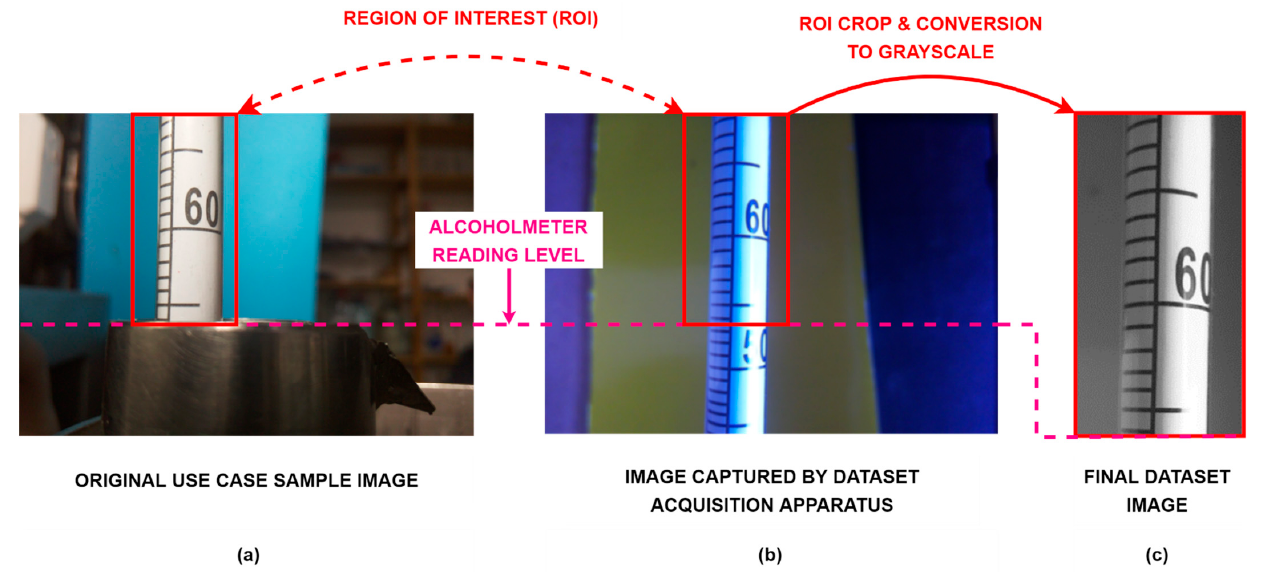
Figure 8. Illustration of dataset image generation and preprocessing procedure: ( a ) Original use case sample image is displayed with region of interest (ROI) labeled with red rectangle and alcoholmeter reading level labeled with pink dashed line; ( b ) Image captured by dataset acquisition apparatus together with ROI corresponding to original use case ROI and alcoholmeter reading level; ( c ) Final dataset image generated by cropping image acquired by apparatus to corresponding ROI and con- verting it to grayscale.